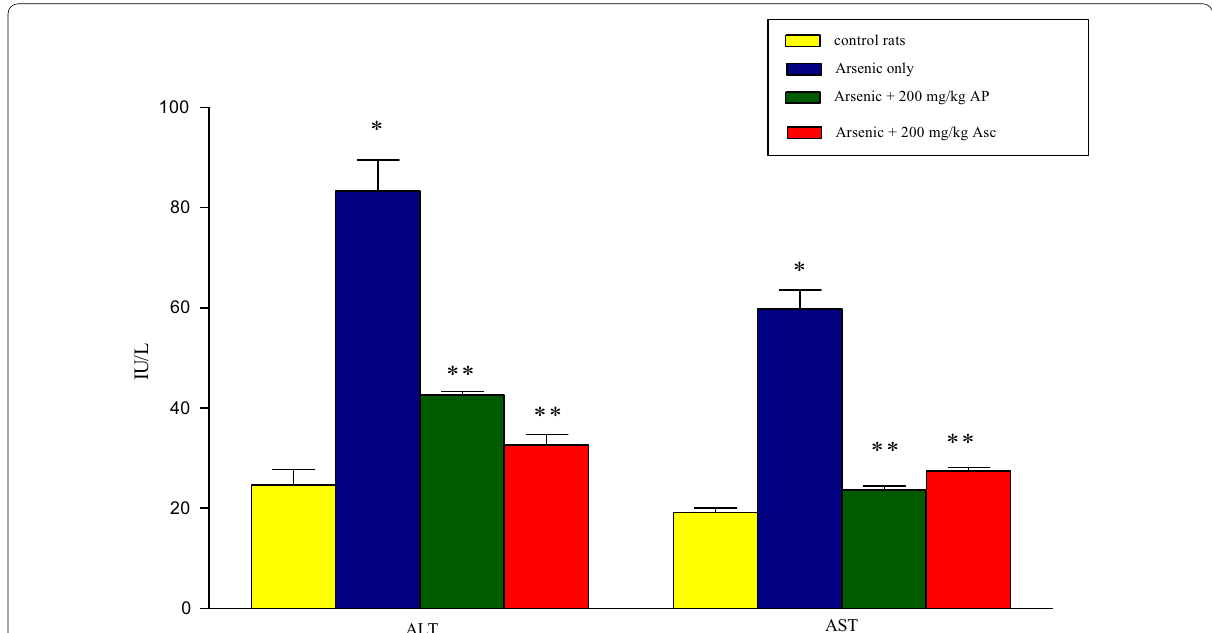
Fig. 1 Effect of methanolic extract of A. paniculata on activities of ALT and AST in arsenic-induced rats. Values are mean Group 2: (arsenic group rats) compared with group 1: (control rats). **( p < 0.05) Groups 3 and 4: ( A. paniculata or ascorbic acid administered rats, respectively) compared with group 2: (arsenic group rats)